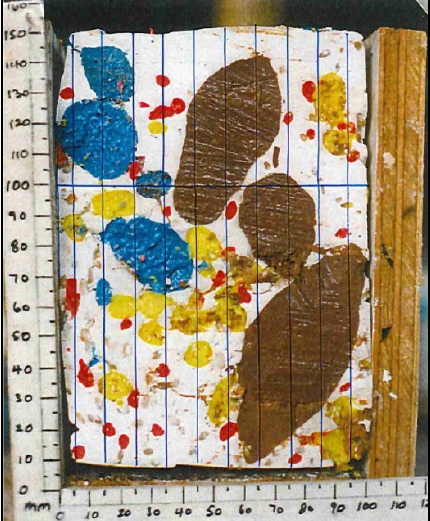
Figure 1. Scanlines (blue) traced on 42% physical bimrock model (original of monochrome image of Figure 3 of Medley’s [43] work).